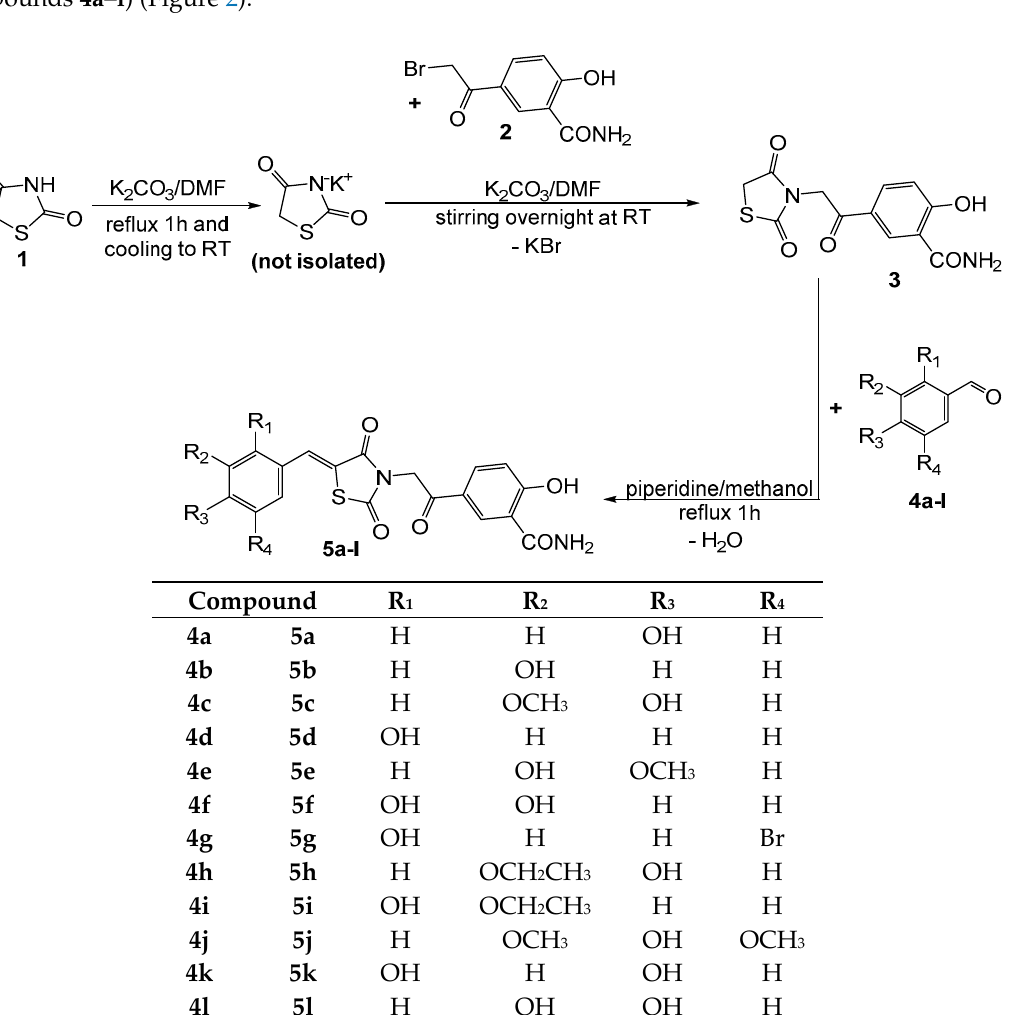
Figure 2. The synthetic route followed in order to obtain the final compounds 5a – l .